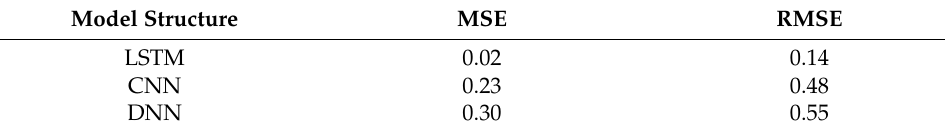
Table 8. Evaluation results of LSTM, CNN, and DNN models. Model Structure